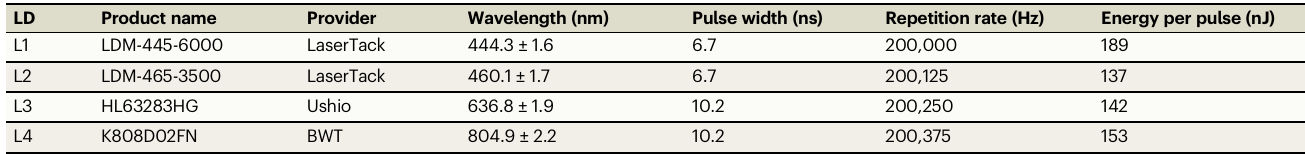
Table 1 | Summary of laser diode pulsing and emission characteristics in Frequency Multiplexed Optoacoustic Tomography